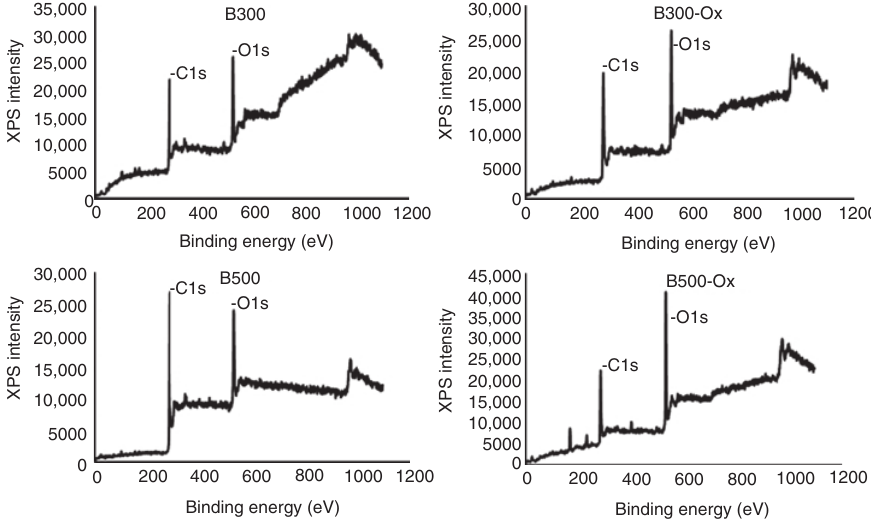
Figure 1: X-ray photoelectron spectra (XPS) of biochars and oxidized biochars.